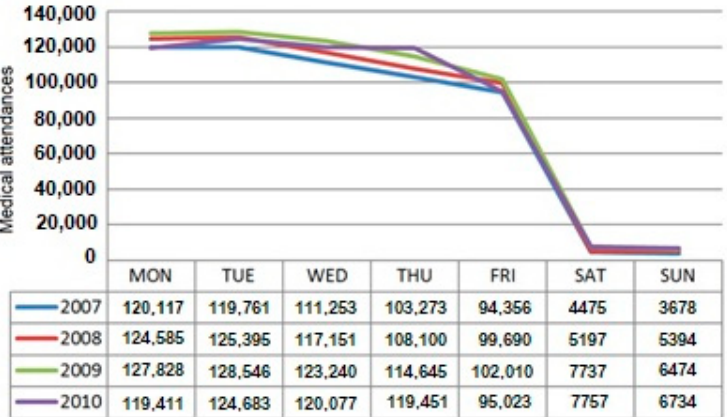
Figure 2. Distribution of medical attendances grouped by days of the week from 2014 to 2017.